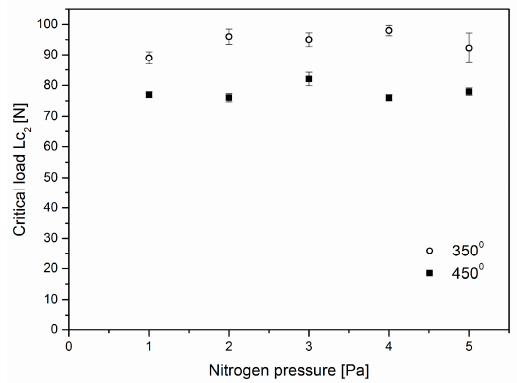
Figure 11. Critical load ( L c2) of the coatings deposited using different nitrogen pressure and substrate bias voltage U B = − 100 V.